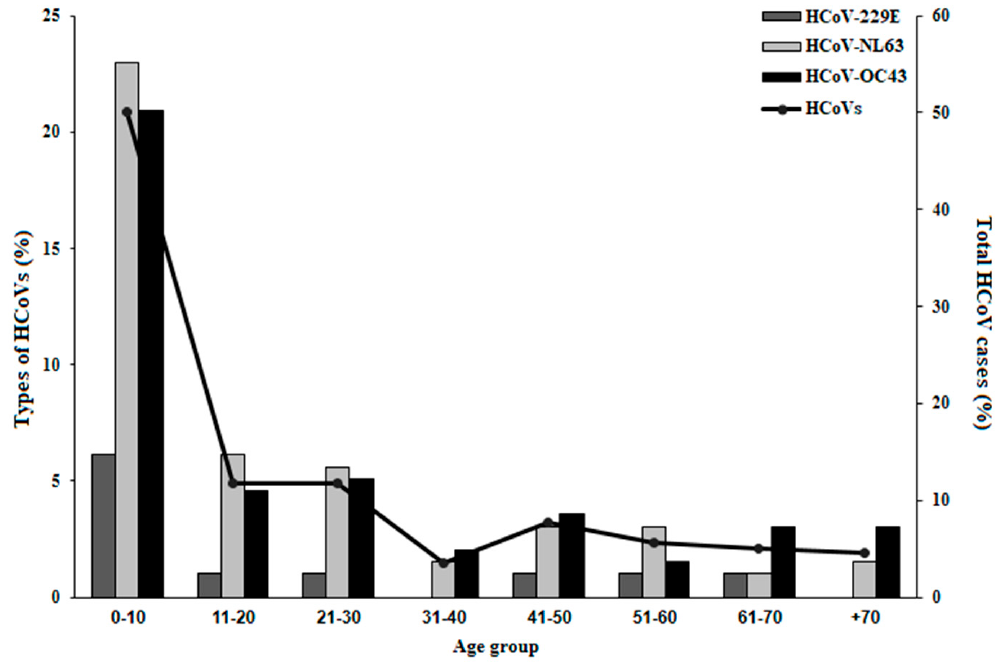
Figure 2. Age distribution of the HCoV-infected patients. The percent of all HCoV-positive cases (Line, Right Y-axis) and of each HCoV type (Bars, Left Y-axis) per patient age groups.